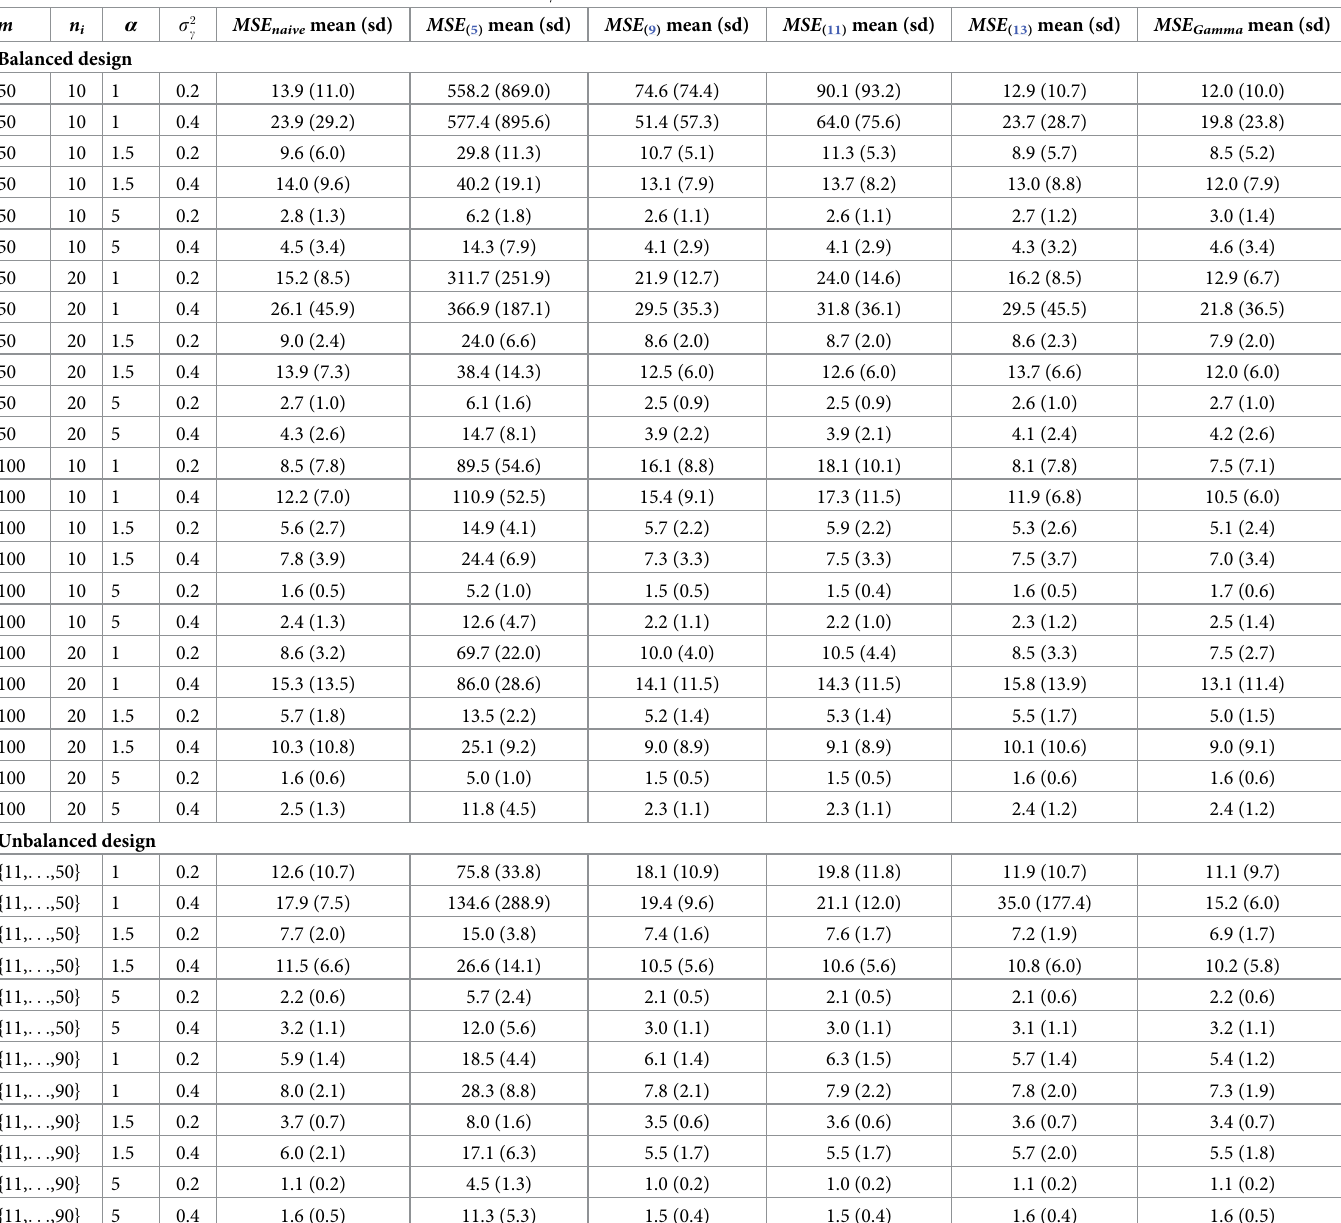
; for data simulated from a GLMM with gamma distribution and logarithmic g